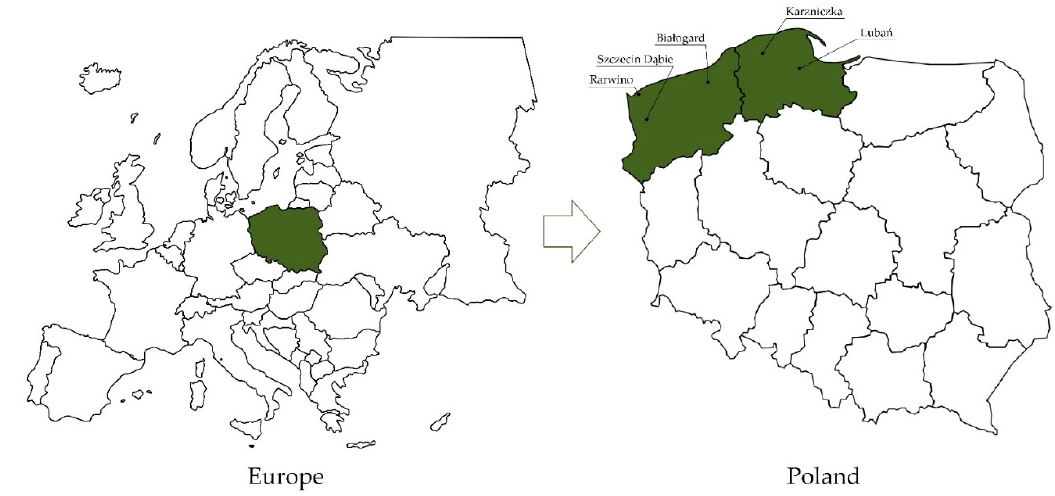
Figure 1. Experiment stations—selected research area.